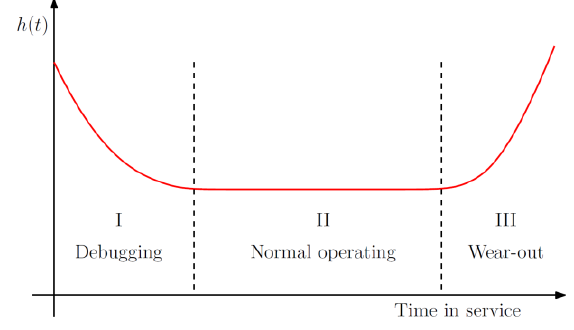
Fig. 9. Component failure rate versus time in service (bathtub